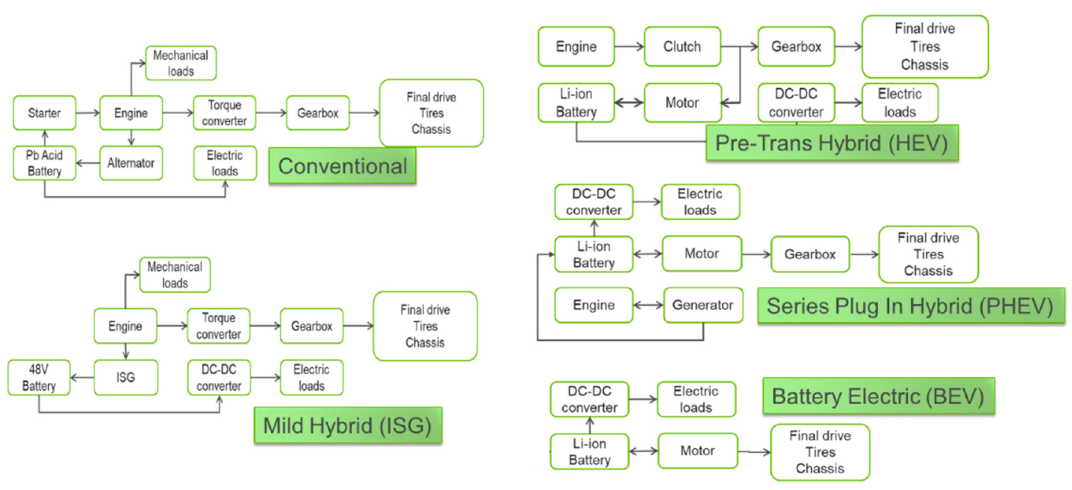
Figure 1. Layout in powertrain architectures considered in this work.